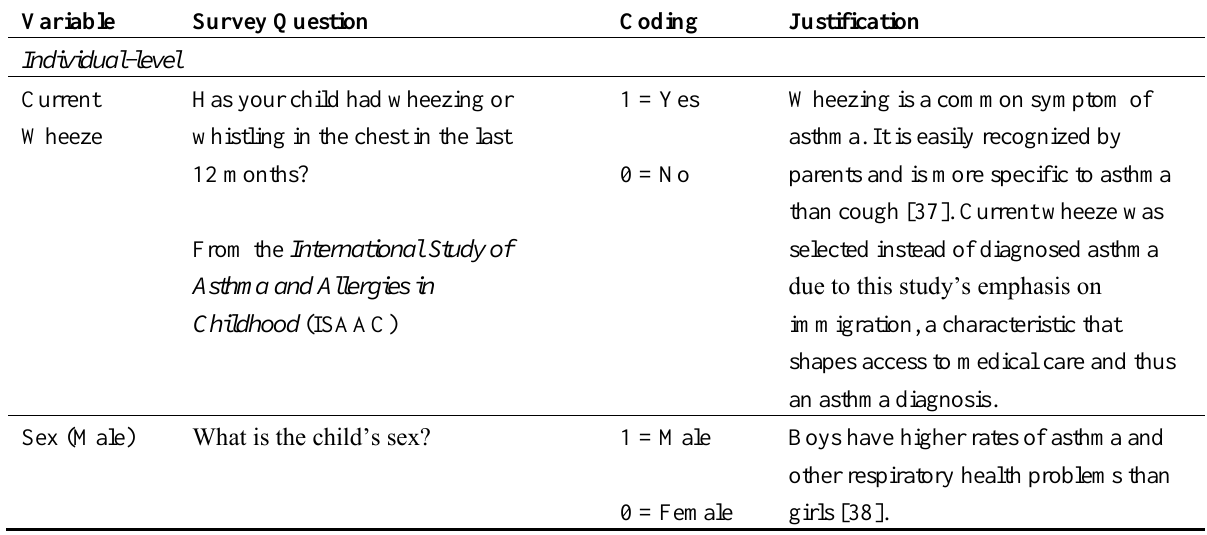
Table 1. Analysis variables: survey question, coding, and